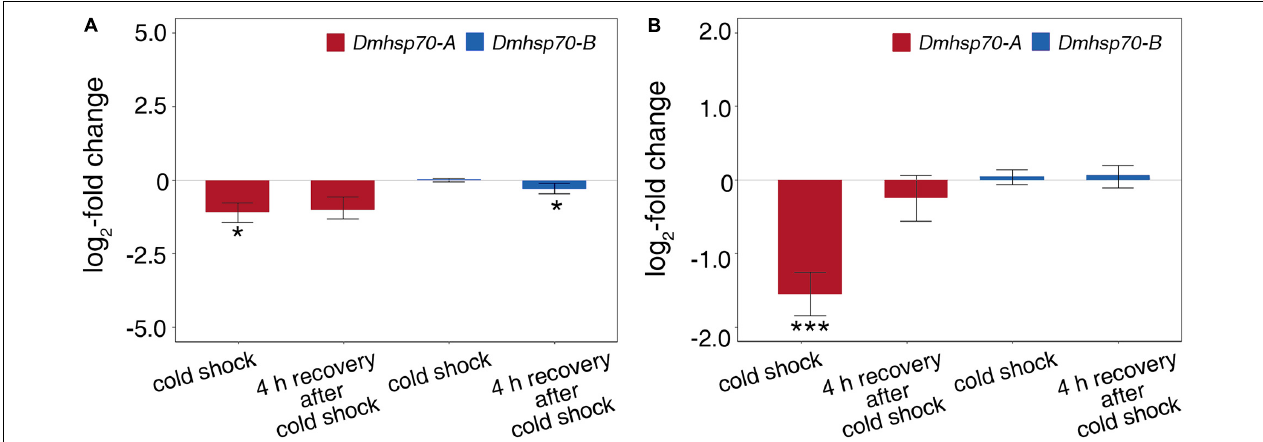
FIGURE 6 | Relative fold change (in log 2 scale) in transcript level of Dmhsp70-A and Dmhsp70-B upon cold shock in developing cells from D. magna asexually produced embryos (A) and diapausing cells from D. magna sexually produced embryos (B) . Displayed is expression at each treatment relative to non-stressed control treatment. Error bars represent standard error ( n = 3). P -values are indicated by asterisks: * P ≤ 0.05, *** P ≤